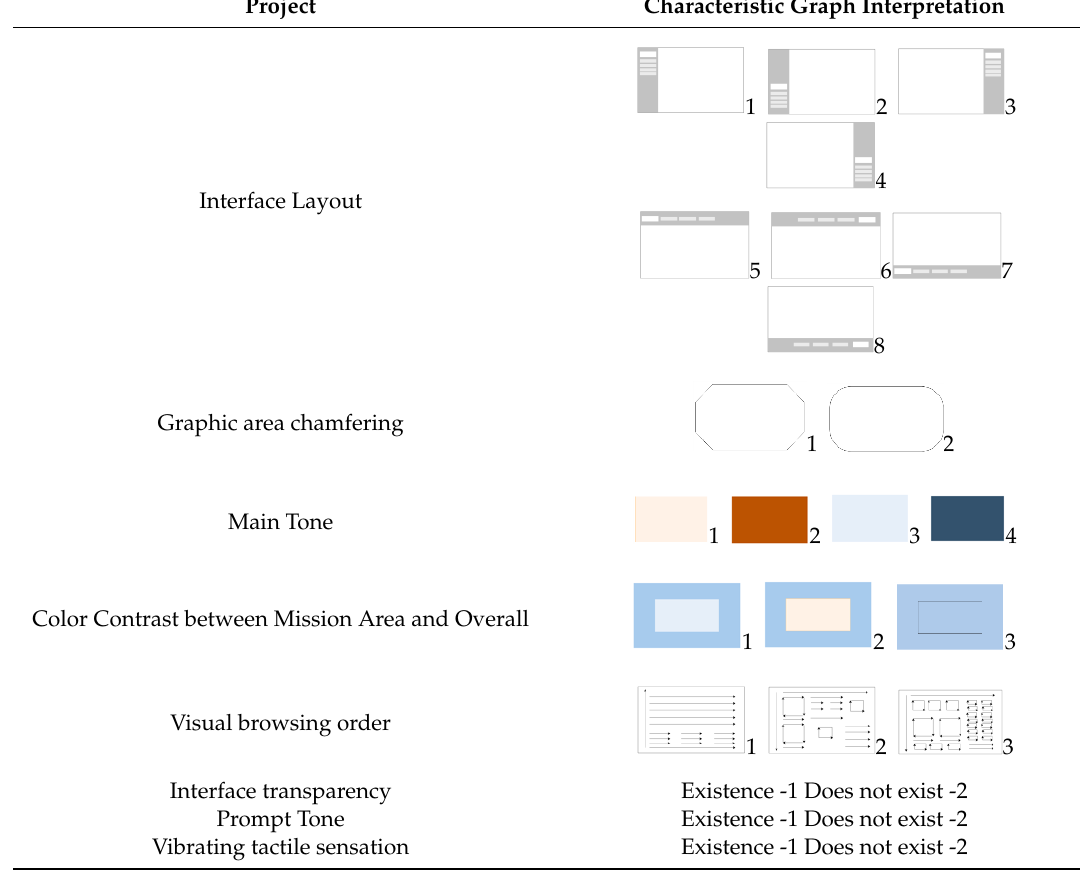
Figure 8. UE4 Sensory channel interactive experience coding blueprint.